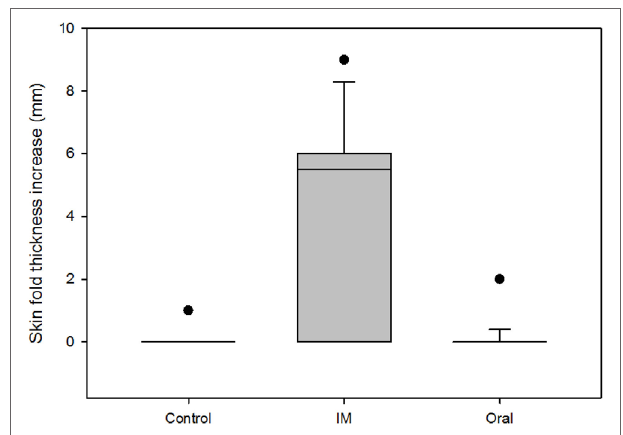
FigUre 1 | Comparison of the skin fold thickness increase (mm) at the bovine purified protein derivative (PPD) site among groups 2 months after booster vaccination. Boxes represent the lower, median, and higher quartile ranges and “outliers” are represented by closed